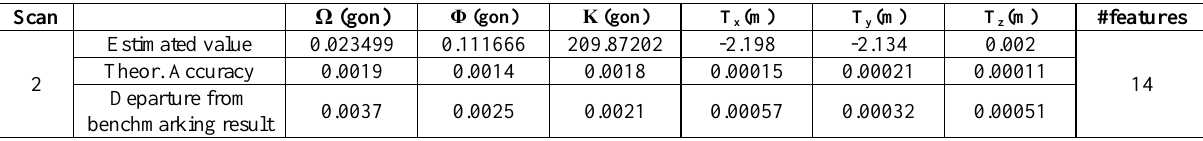
Table 3. Statistical results for ‘Classroom’ data